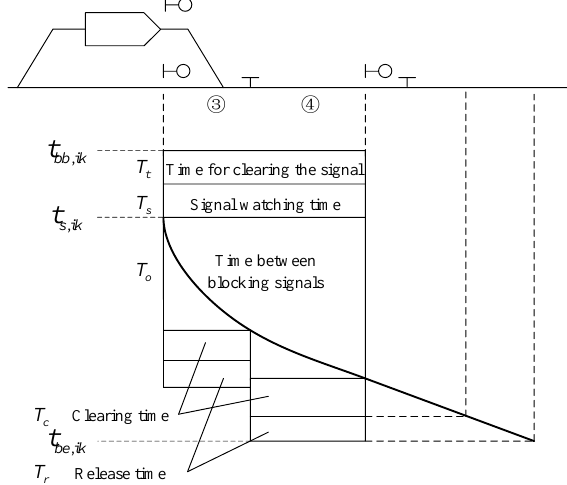
Figure 5. Diagram of the composition of the blocking time when a train leaves a station.